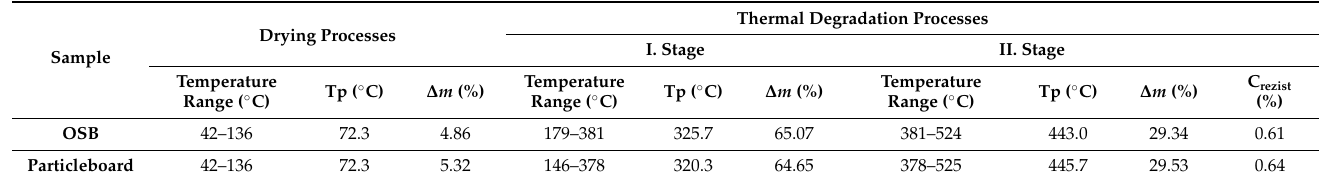
Table 6. Thermogravimetric analysis of OSB and particleboard